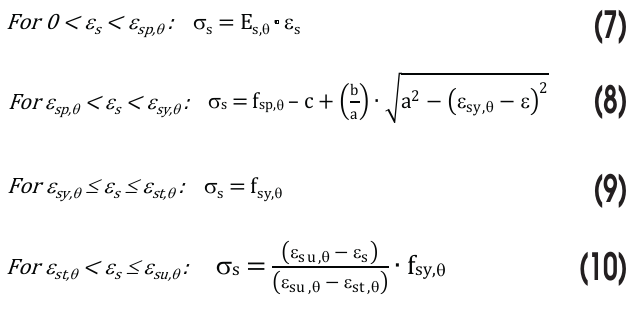
Values for the parameter E